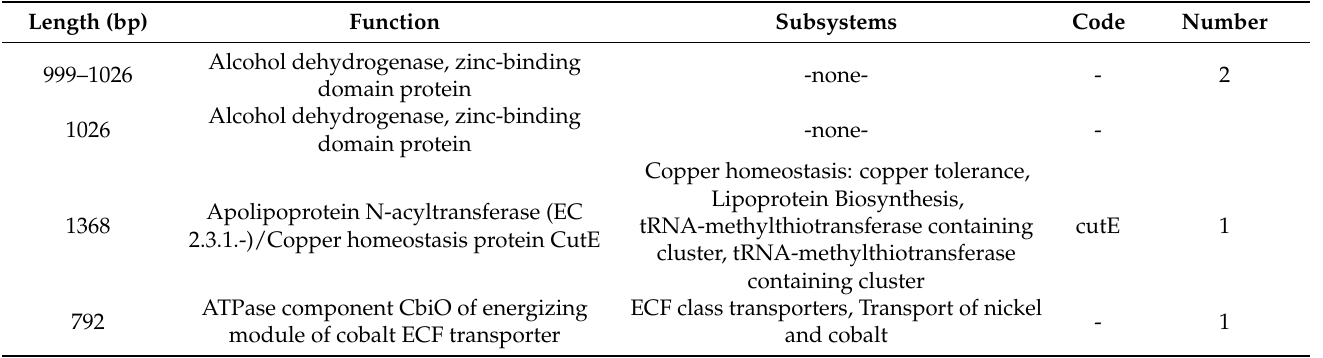
Table 2. List of genes related with the heavy metal tolerance or transport localized in Plantactinospora sp. S1510 T